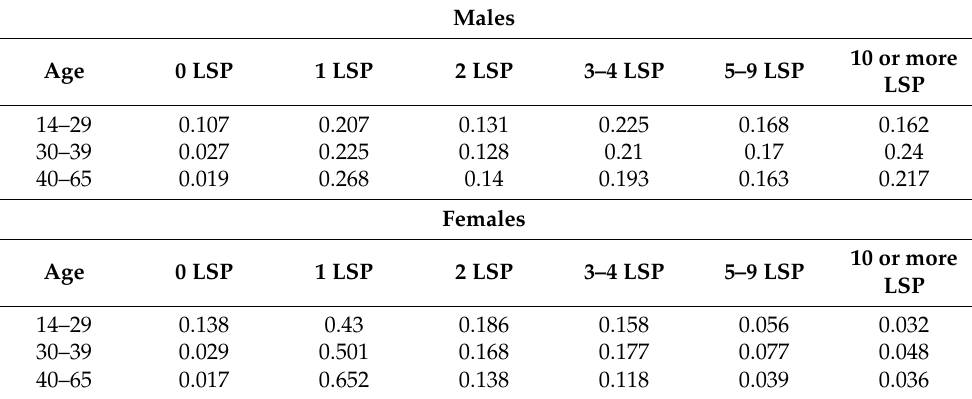
Table 1. Proportion of males and females per number of lifetime sexual partners per age